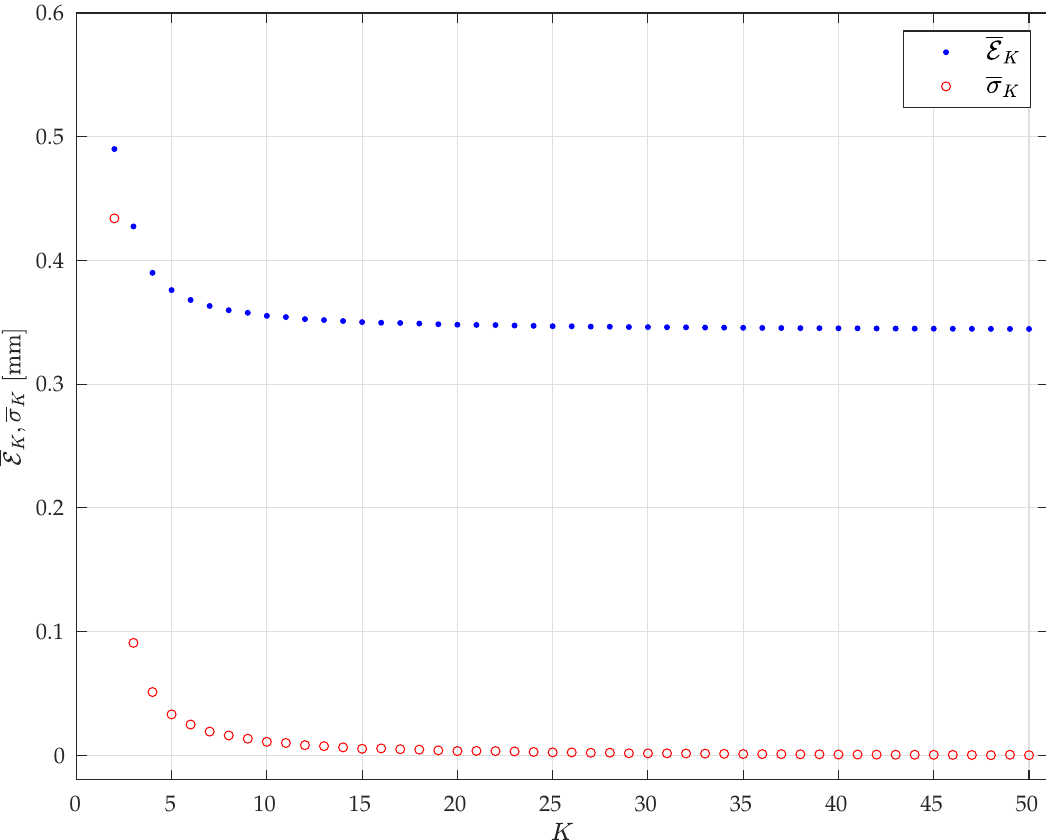
(blue dots) and their RMS σ K (red circles) for E K